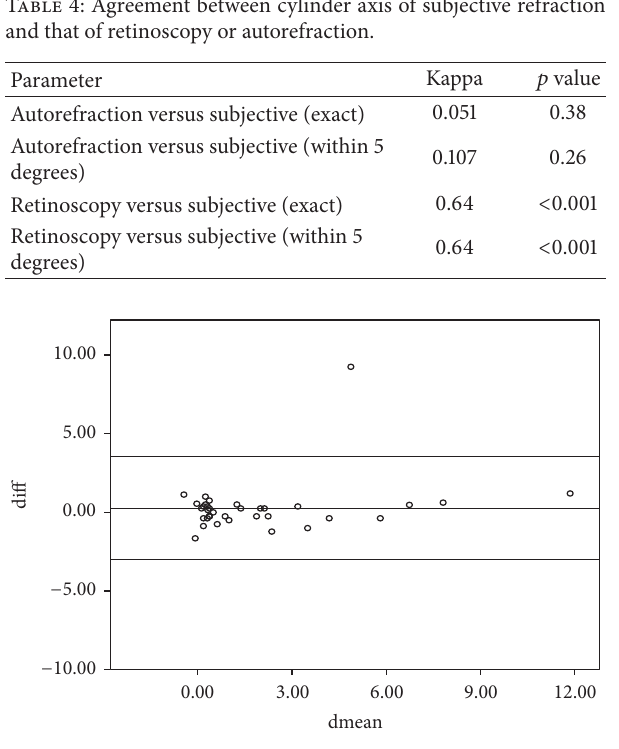
Figure 2: Bland-Altman plots comparing refractive measurements between autorefraction and subjective refraction (spherical equiva- lent).